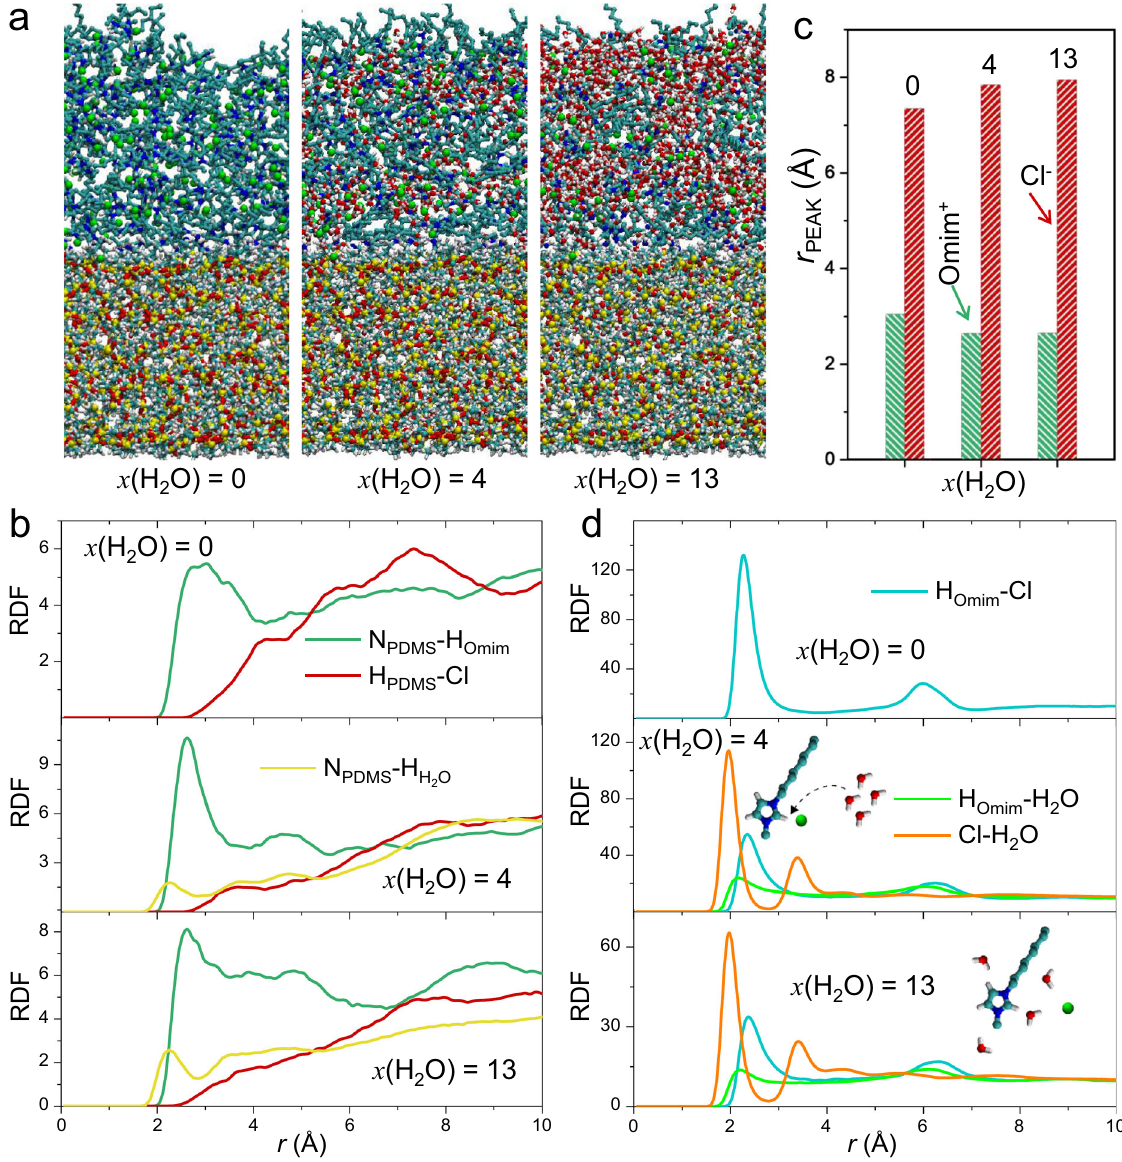
Fig. 5 Moisture in fl uenced N PDMS -Omim + and Omim + -Cl − interactions. a The interfacial model of N PDMS and IL-water mixtures in the MD simulations. b The RDF for various atom pair: N PDMS – Omim + (dark green), N PDMS – Cl − (red), and N PDMS – H 2 O (yellow). c The position of the fi rst peak of RDF between ILs and PDMS for various water content. d The RDF of the atom pair: Omim + – Cl − (blue), Omim + – H 2 O (bright green), and Cl − – H 2 O Fig. 6b. Surprisingly, we fi nd the enhance factor for x (H 2 O) = 13 is (Fig. 6c), in contrary with x (H 2 O) = 0 that the charge distribution far larger than that for x (H 2 O) = 4, especially when the pressure oscillates wildly due to the not further distinguished migration of gradient is small. The movement difference between cation and the intimate ion pairs. All these results indicate the critical role of anion near PDMS wall indicates the possibility of fl ow-triggered water for our power generation mechanism. charge accumulation. Fig. 5, the nano-con fi ned space within PDMS nanowire array also restricts the movement of Omim + , which aggregates dynamically to form clusters under hydrophobic interactions. We fi nd from Supplementary Fig. 9, larger ionic clusters (containing ~170 atoms) form in bulk IL with both x (H 2 O) = 4 and x (H 2 O) = 13. Overall, slowed movement of moisture-clustered Omim + within con fi ned PDMS nanowire array gaps integrated with moisture-enhanced af fi nity of Omim + onto nanowire walls enables Omim + /Cl − separation upon fl ows across PDMS/IL interfaces. MD simulation shows the interfacial charge strati fi cation when x (H 2 O) = 4 and 13